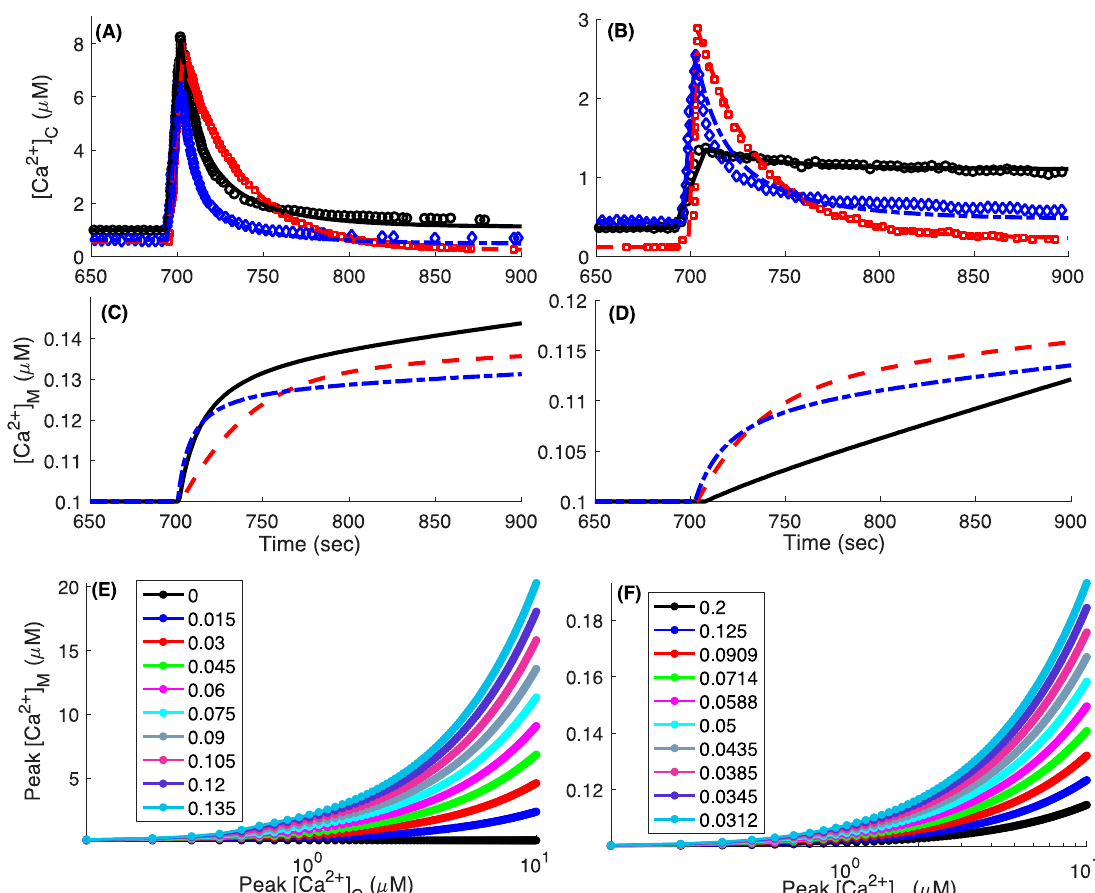
Figure 3. Model fits to the whole-cell cytosolic Ca 2 + traces observed in the cell culture experiments and the e ff ect of mitochondrial Ca 2 + bu ff ering capacity and relative size with respect to cytoplasm on free mitochondria Ca 2 + . ( A ) [Ca 2 + ] C in WT (spheres, solid line), MICU1 KO (squares, dashed line), MICU2 KO (diamonds, dashed-dotted line) cells. Symbols and lines represent experimental observations and model fits respectively. Cells were treated with 0.004% digitonin to permeabilize plasma membrane, 2 µ M thapsigargin to block ER Ca 2 + uptake, and 20 µ M CGP37157 to inhibit mitochondrial Ca 2 + e ffl ux, added at t = 50, 100, and 400 s, respectively. After reaching steady state, a bolus of Ca 2 + was added to the cytoplasm at ~700 s to raise [Ca 2 + ] C to above 7 µ M. ( C ) [Ca 2 + ] M given by the model. Results in ( B , D ) are similar to ( A , C ) except that the bolus of Ca 2 + added was smaller. Peak [Ca 2 + ] M 300 s after the Ca 2 + bolus was added as a function of maximum [Ca 2 + ] C in WT cells as we change f m ( E ) and δ ( F ). The legends in ( E , F ) respectively represent the values of f m and δ used. In all simulations shown in Figure 3, a fixed mitochondrial membrane potential ∆ ψ = − 160 mV is used. Experimental data shown for comparison are from [12] ( A , B ).